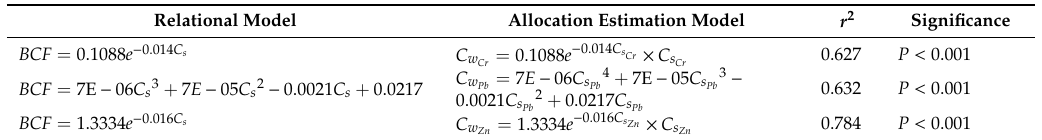
Table 6. The optimal allocation estimation model of the Cr, Pb and Zn concentrations in the soil-wheat system.